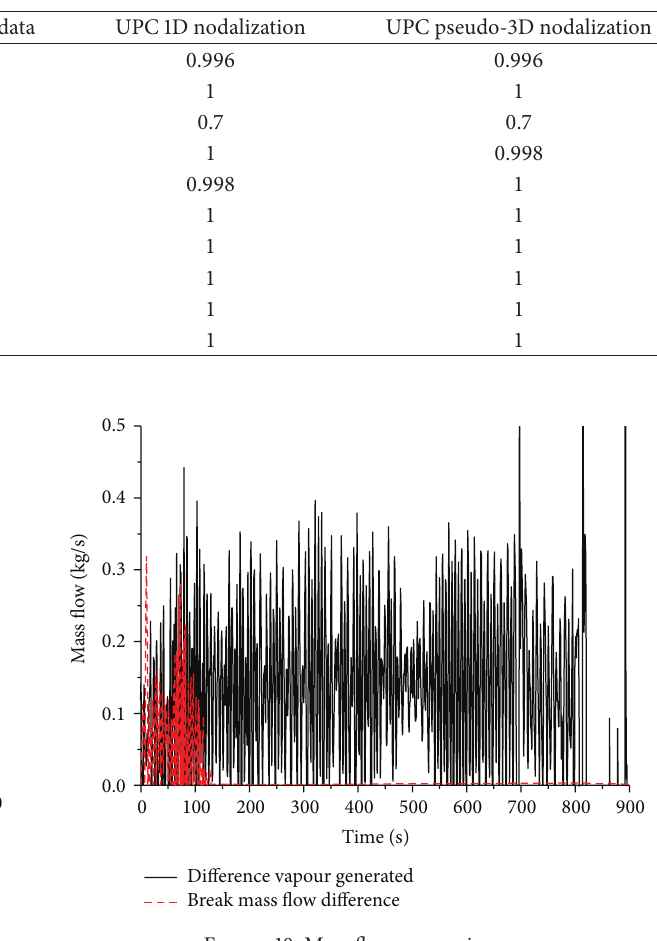
Table 3: Initial conditions of PKL G7.1 Test.